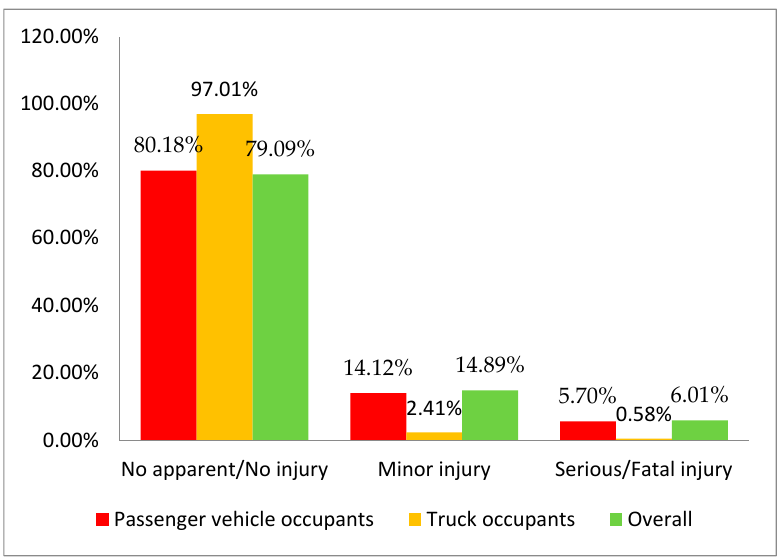
Figure 2. Most severe injury severity distributions in passenger vehicle–truck involved collisions.